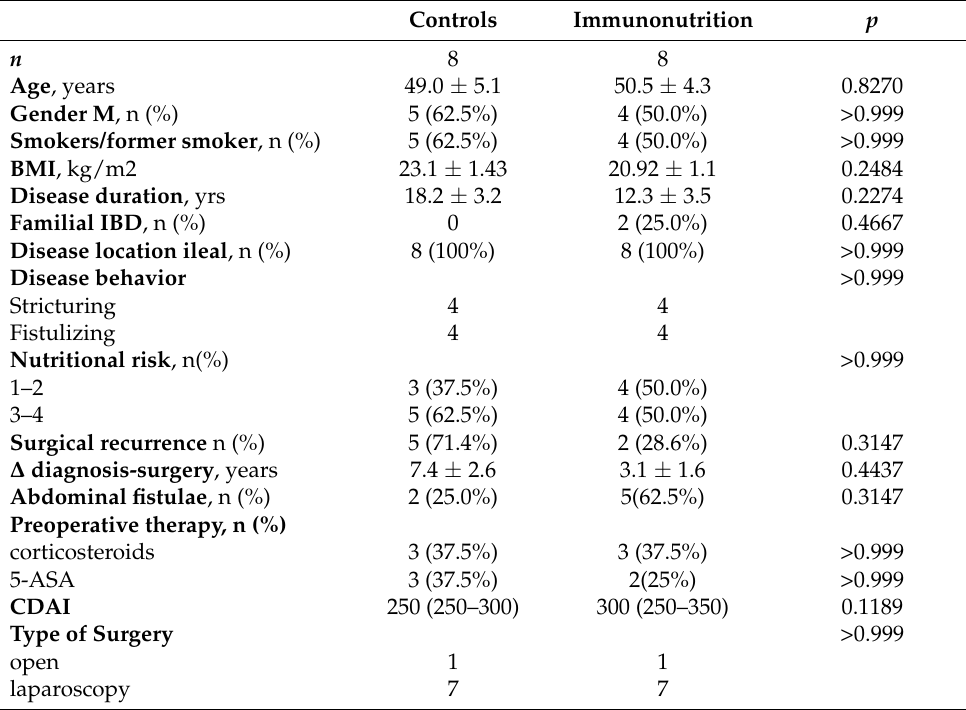
Table 1. Demographics and clinical characteristics of the two groups of Crohn’s disease patients. Controls Immunonutrition